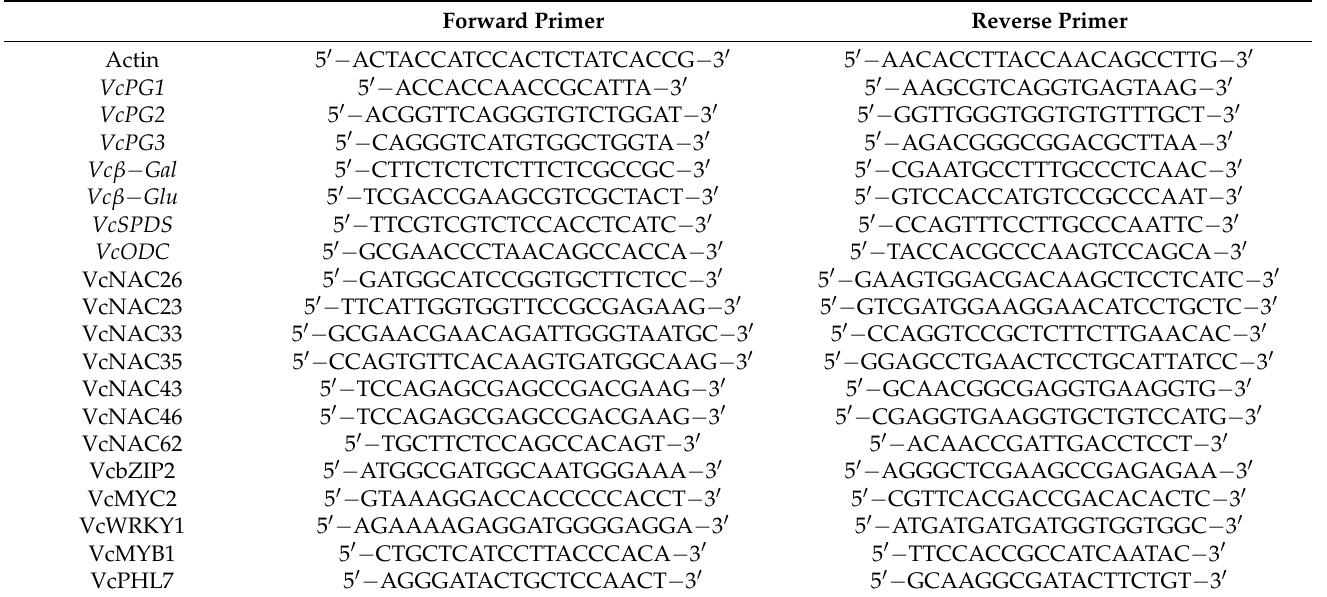
Table 1. Primers for RT − qPCR